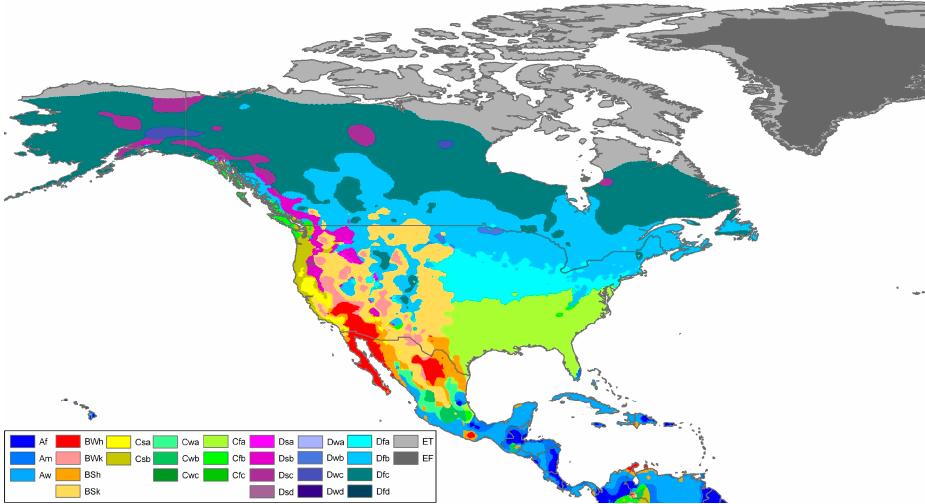
Figure 1. Koppen-Geiger climatic map of North America. (Image by Peel, M. C., Finlayson, B. L., and McMahon, T. A. (University of Melbourne) (CC BY-SA 3.0 (http://creativecommons.org/licenses/by- sa/3.0)), via Wikimedia Commons).